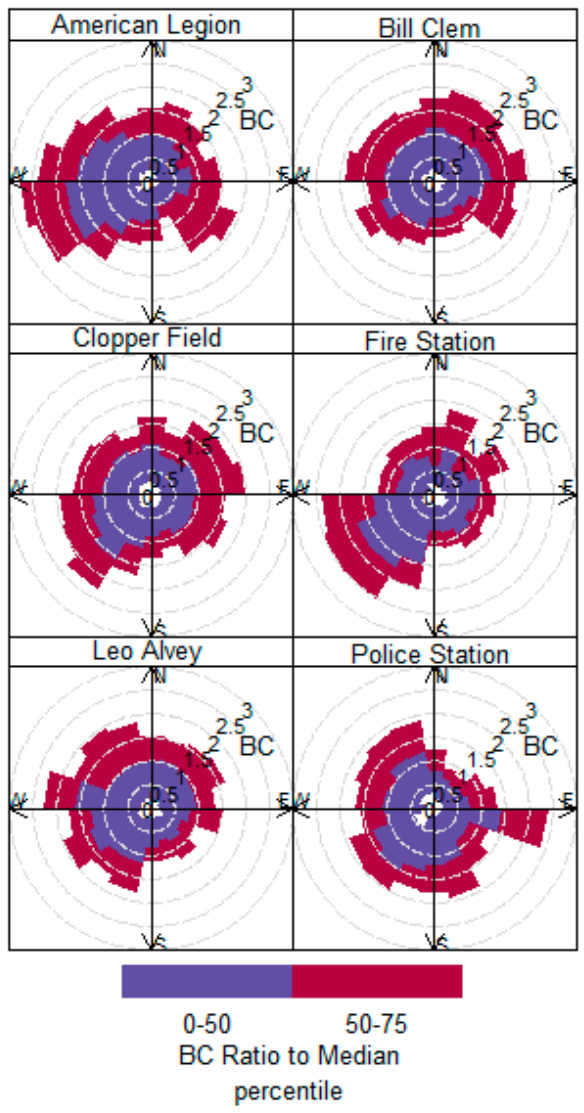
Figure 7. BCIR Pollution rose for all sites.